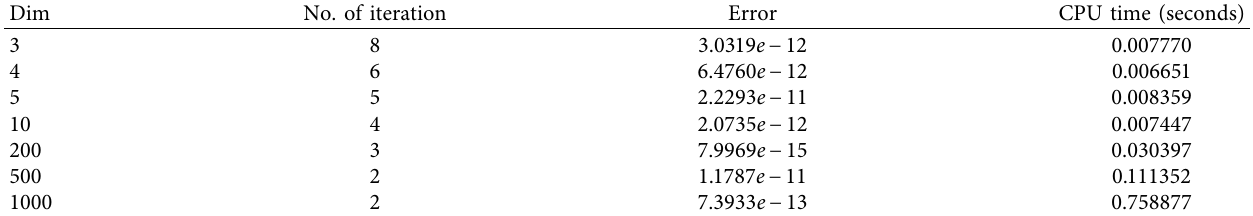
Table 2: CPU analysis for different dimension.